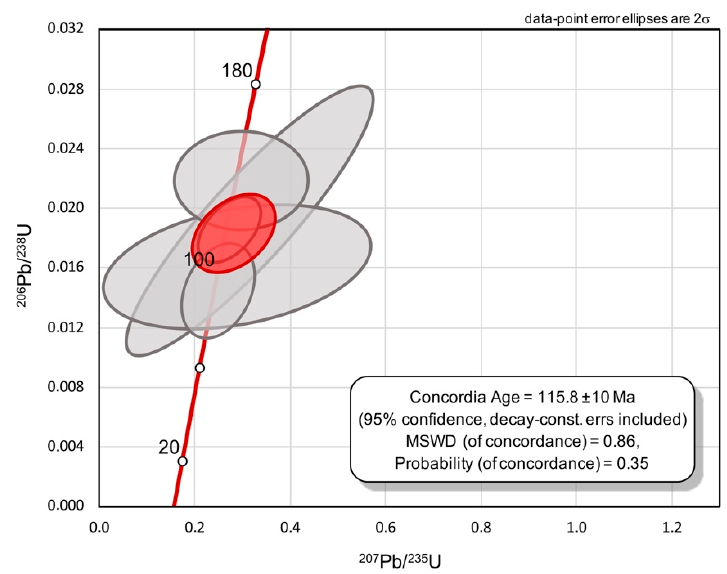
Figure 6. Concordia diagram for the andesitic rock hosting the Romero deposit ore. U–Pb procedures and analytical data are in Sheet-2 (Supplementary Materials).